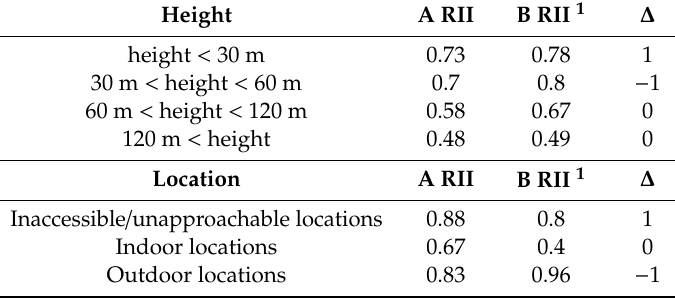
Table 3. Ideal height and location for performing safety operation tasks.